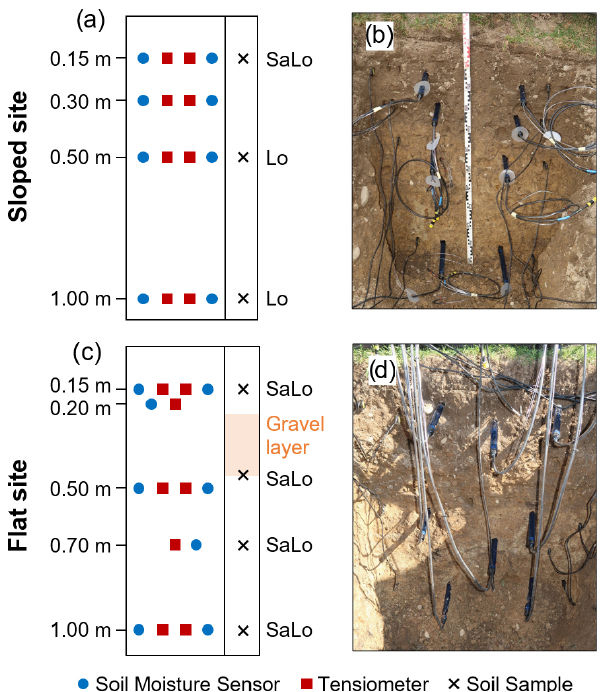
Figure 2. Sensor installation depths and depths of collected soil samples (a, c) , as well as photographs of the profile wall upon in- stallation of the sensors (b, d) . SaLo: sandy loam, Lo: loam .